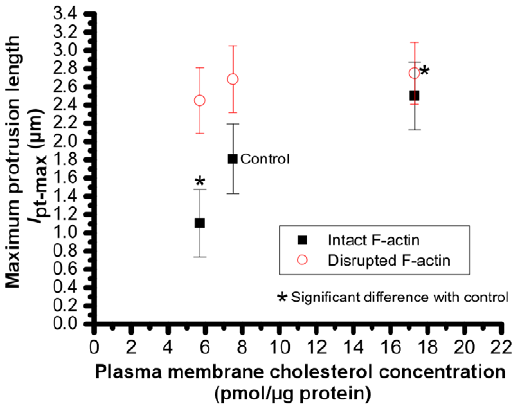
Figure 6. Effect of membrane cholesterol content and cyto- skeletal F-actin on maximum protrusion length. Maximum length of protrusion ( l pt-max ) is defined the length at which the membrane becomes separated from the